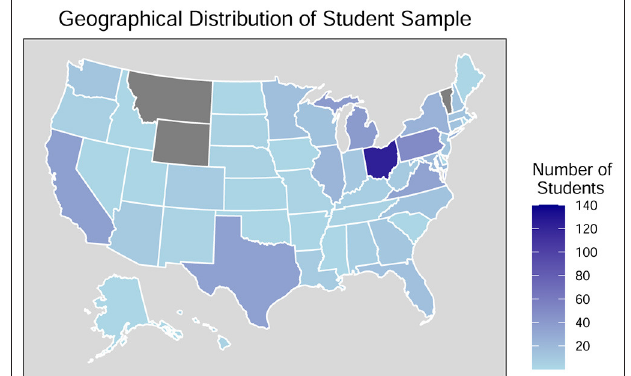
FIGURE 1 | Geographical distribution of student sample during the COVID-19 outbreak ( n = 617). Data excludes those who were not residing in the United States ( n = 7). Gray-colored states reflect no representation in